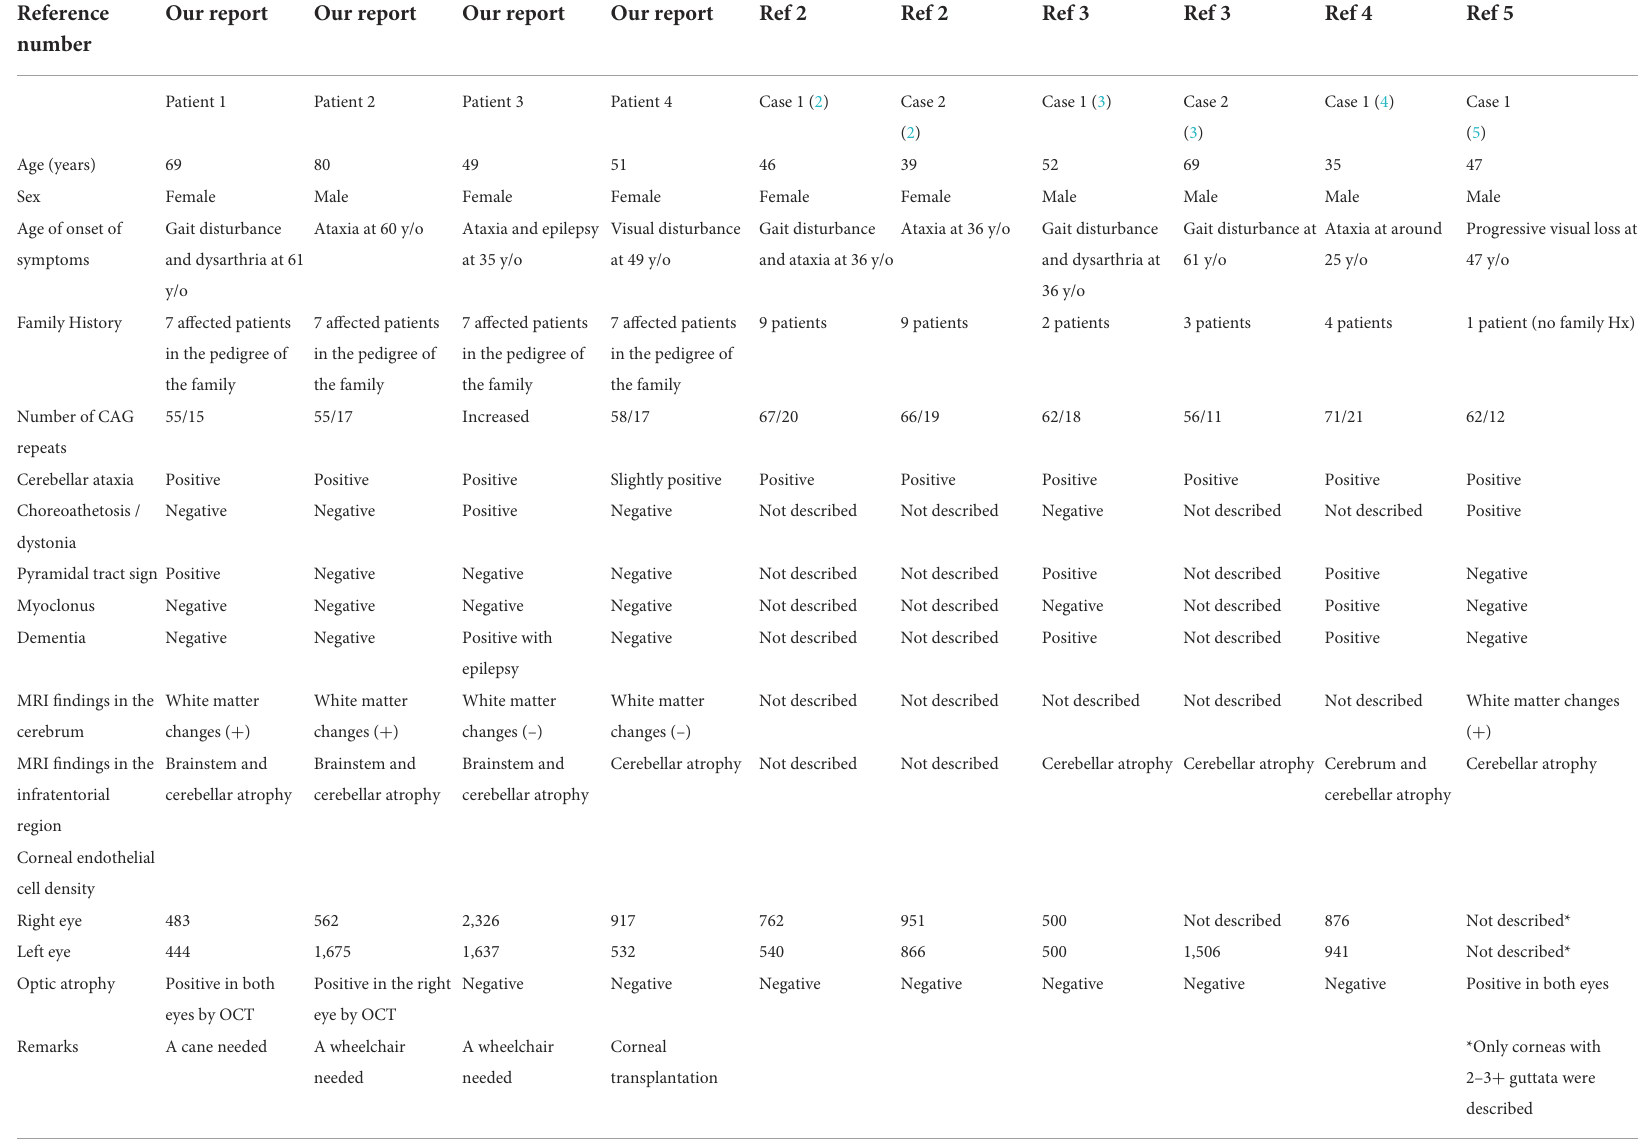
TABLE 1 Summary of patients with dentatorubral-pallidoluysian atrophy (DRPLA) accompanied by ophthalmic lesions, including the four present